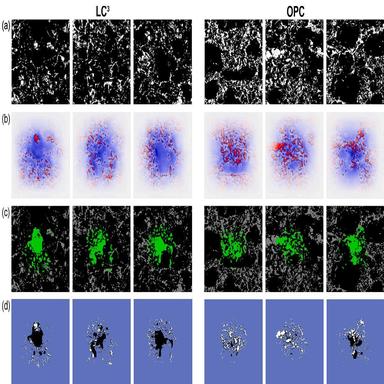
Visualisation and characterisation feature extraction via deep Taylor decomposition. (a) Typical BSE cross-section images of LC3 and OPC with a physical size of 81.12 × 81.12 μm. (b) Locations of characteristic features relevant to DNN decision where red represents low-density areas or pores, and blue represents highdensity areas or solid phases. (c) Locations of the characteristic regions with 70% of the total relevance in characteristic features. (d) Extracted characteristic features at the corresponding